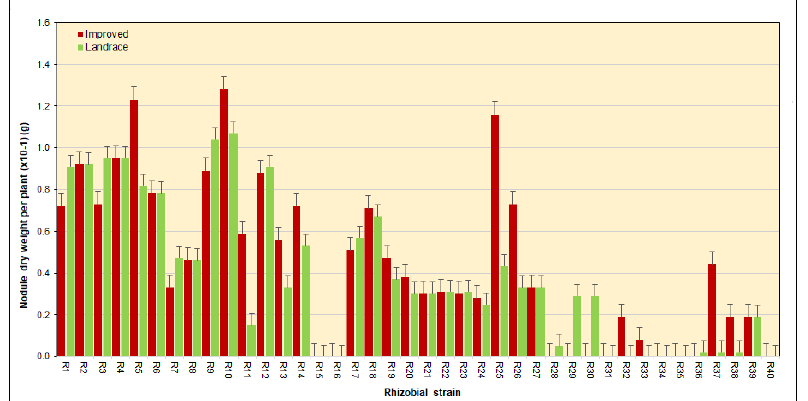
Figure 2. The effects of inoculation with rhizobial strains on the number of nodules per plant of the landrace and improved pigeonpea genotypes. The identity of each rhizobial strain (R1–R40) is de- scribed in Table 2.